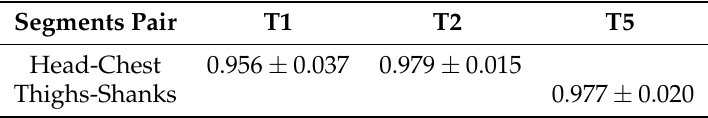
Table 6. Acceleration correlation between body